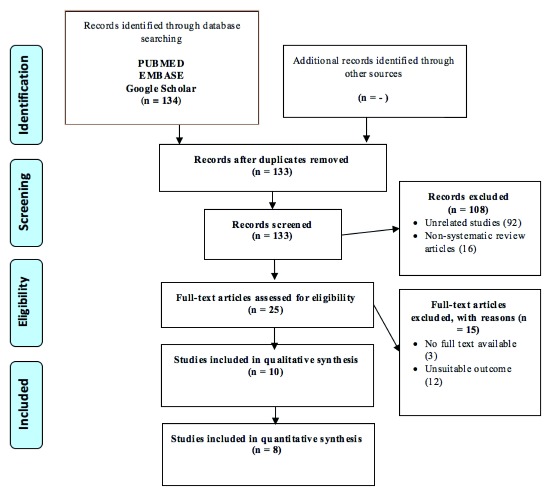
Study flow diagram.